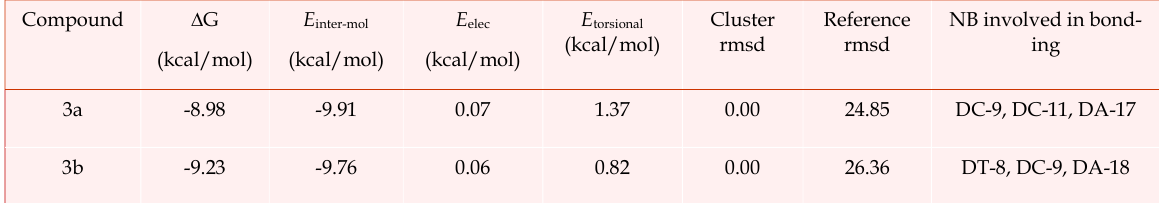
Molecular docking parameters of 3a and 3b with B-DNA dodecamer duplex (PDB ID: 1BNA)